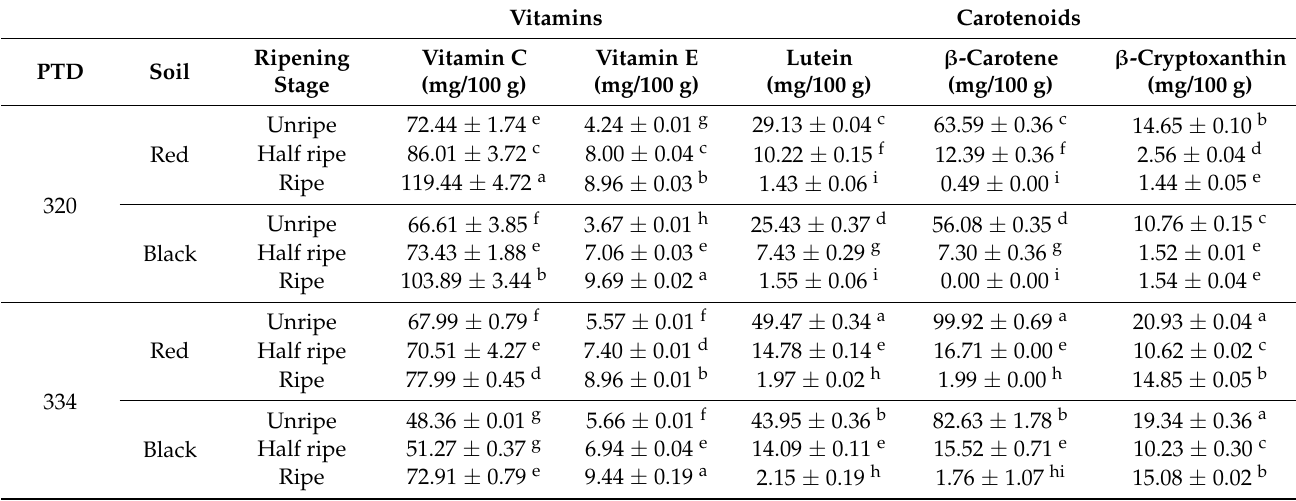
Table 1. Vitamins and carotenoids in unripe (green pepper), half ripe (green-orange pepper) and ripe (orange pepper) Habanero pepper ( Capsicum chinense Jacq.) cultivated in different soils at two PTD. Vitamins